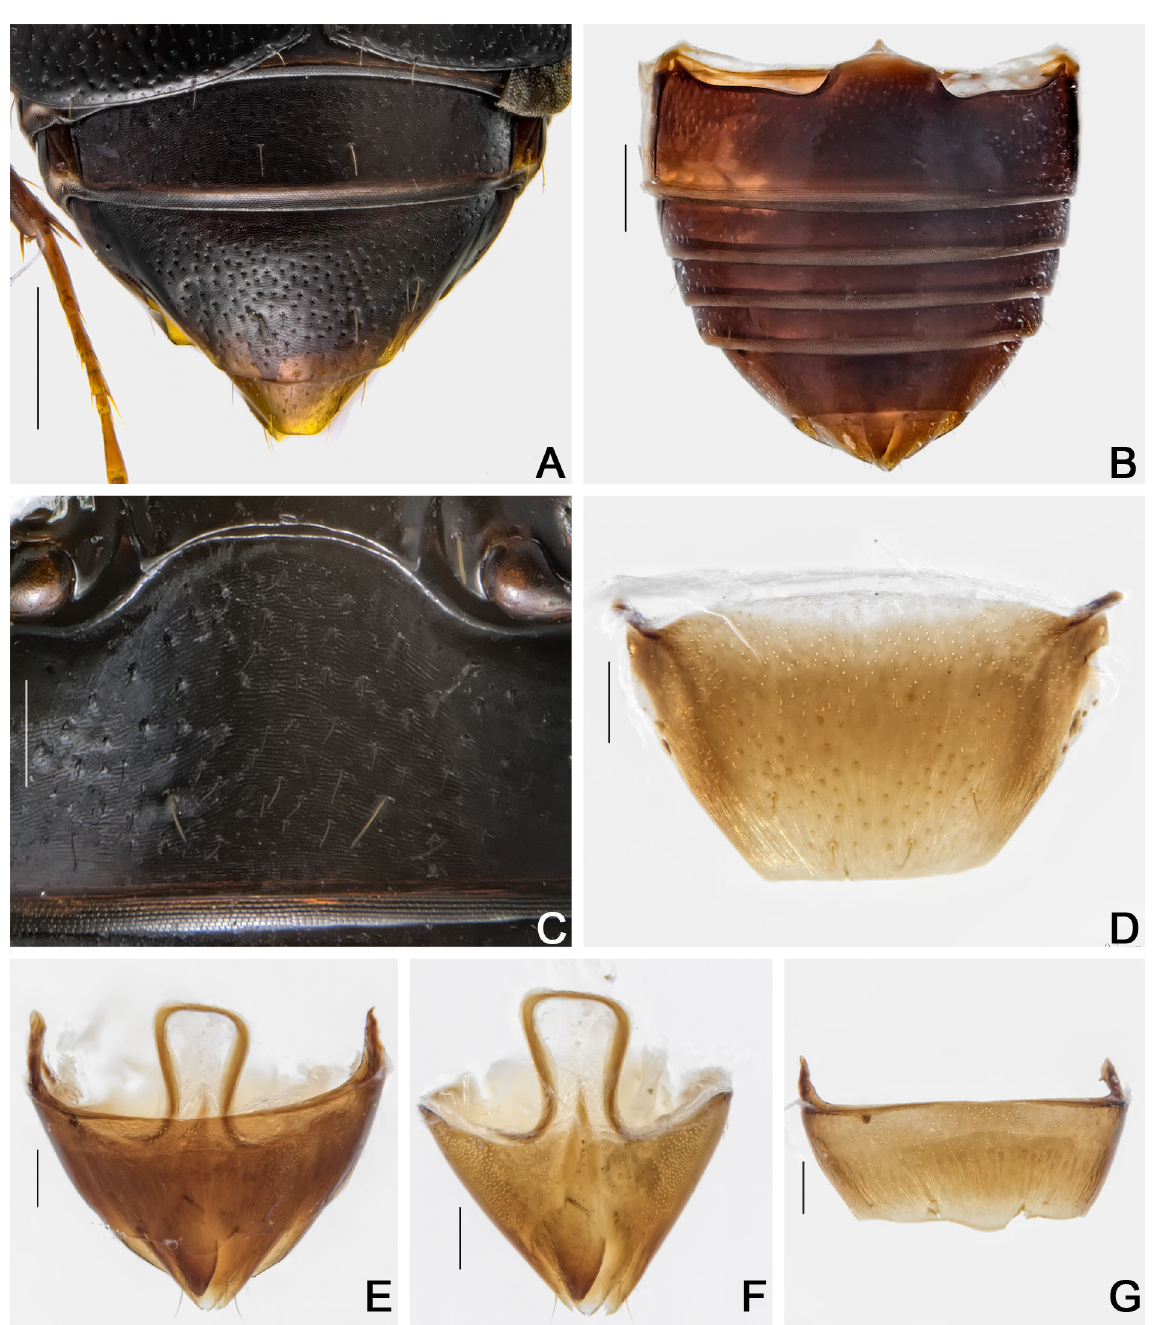
Fig. 43. Cyparium pici sp. nov. A, C . Holotype, ♂ (CEMT). A . Abdomen, dorsal view. B . Paratype, ♂ (CEMT), abdomen, ventral view. C . Ventrite 1. D–G . Paratype, ♂ (CELC). D . Tergite VIII. E . Terminalia. F . Tergite IX. G . Sternite VIII. Specimens collected at Cotriguaçu (MT, Brazil). Scale bars: A–B = 0.5 mm; C–G =